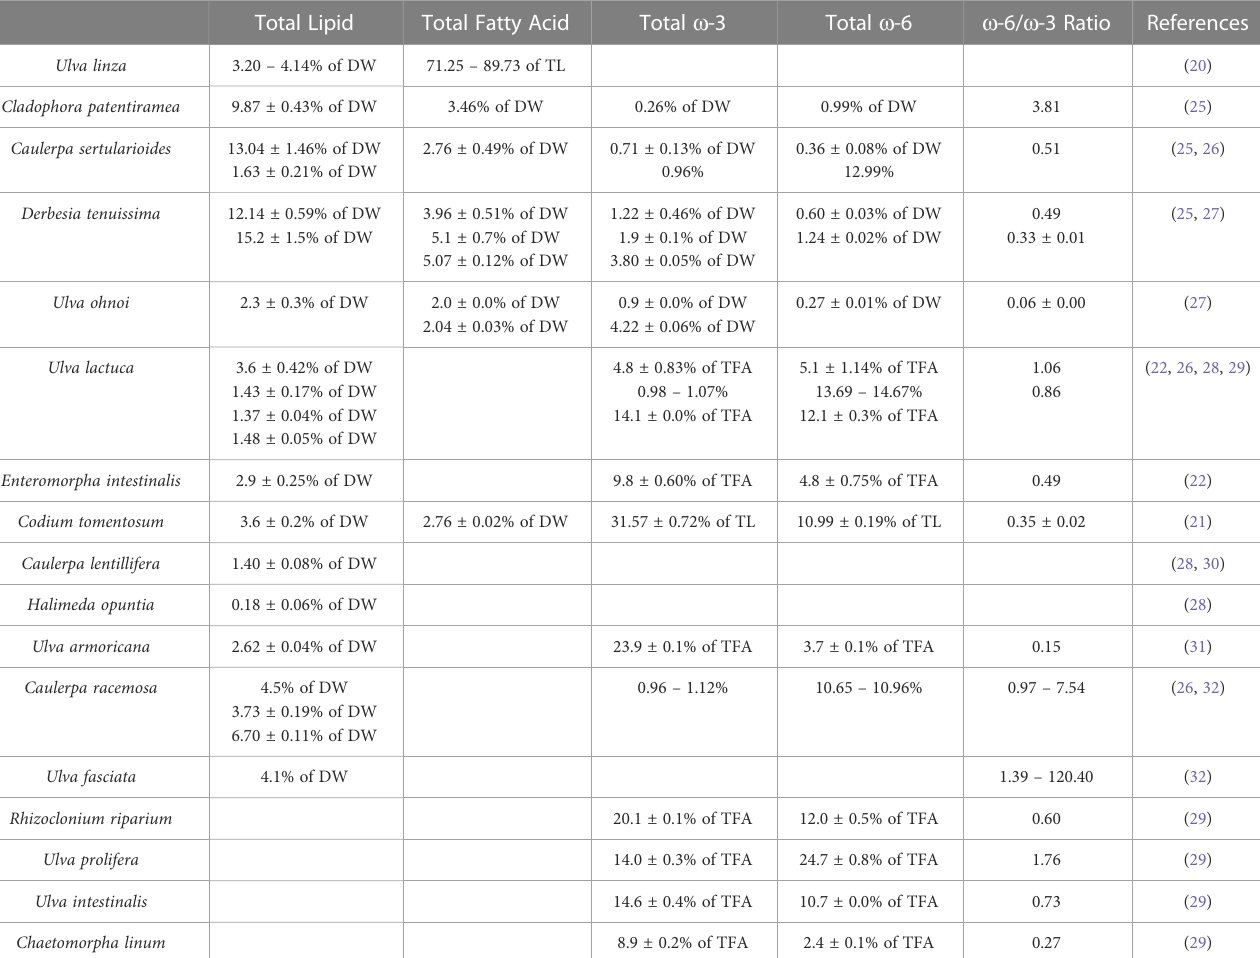
TABLE 1 Content of fatty acids in several green